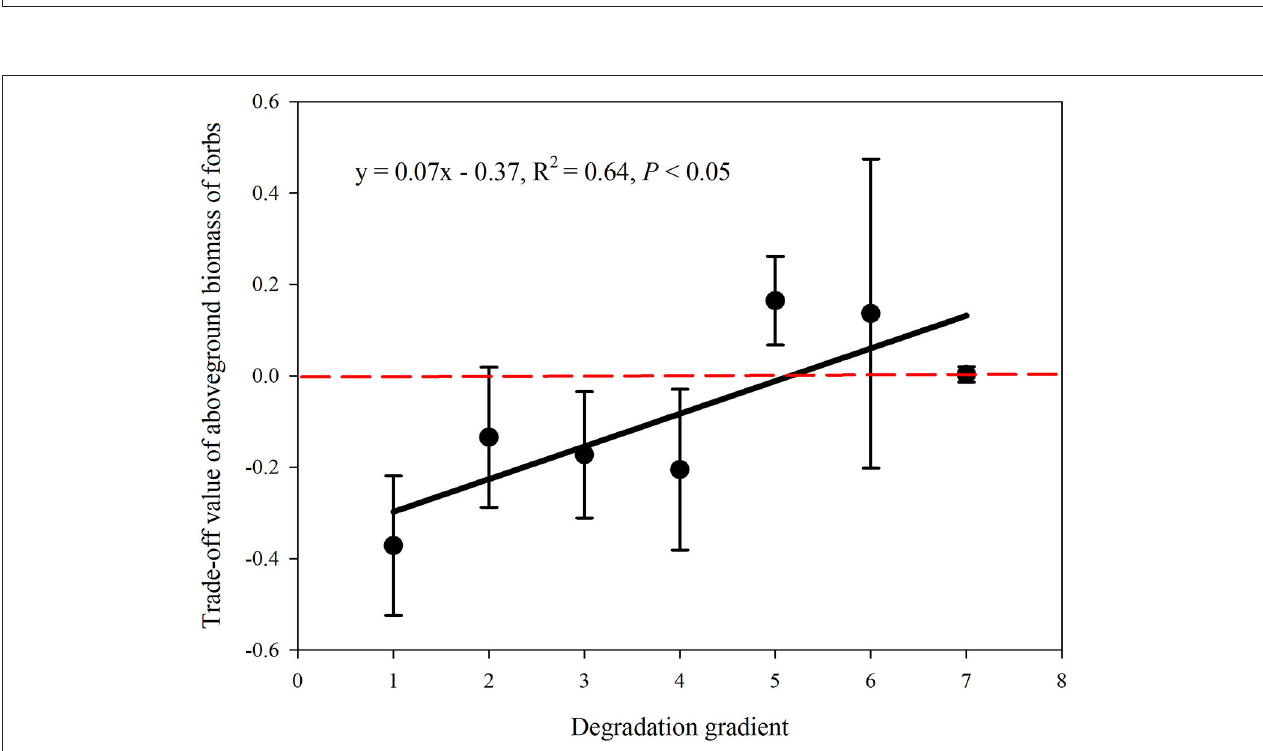
Frontiers in Environmental Science |